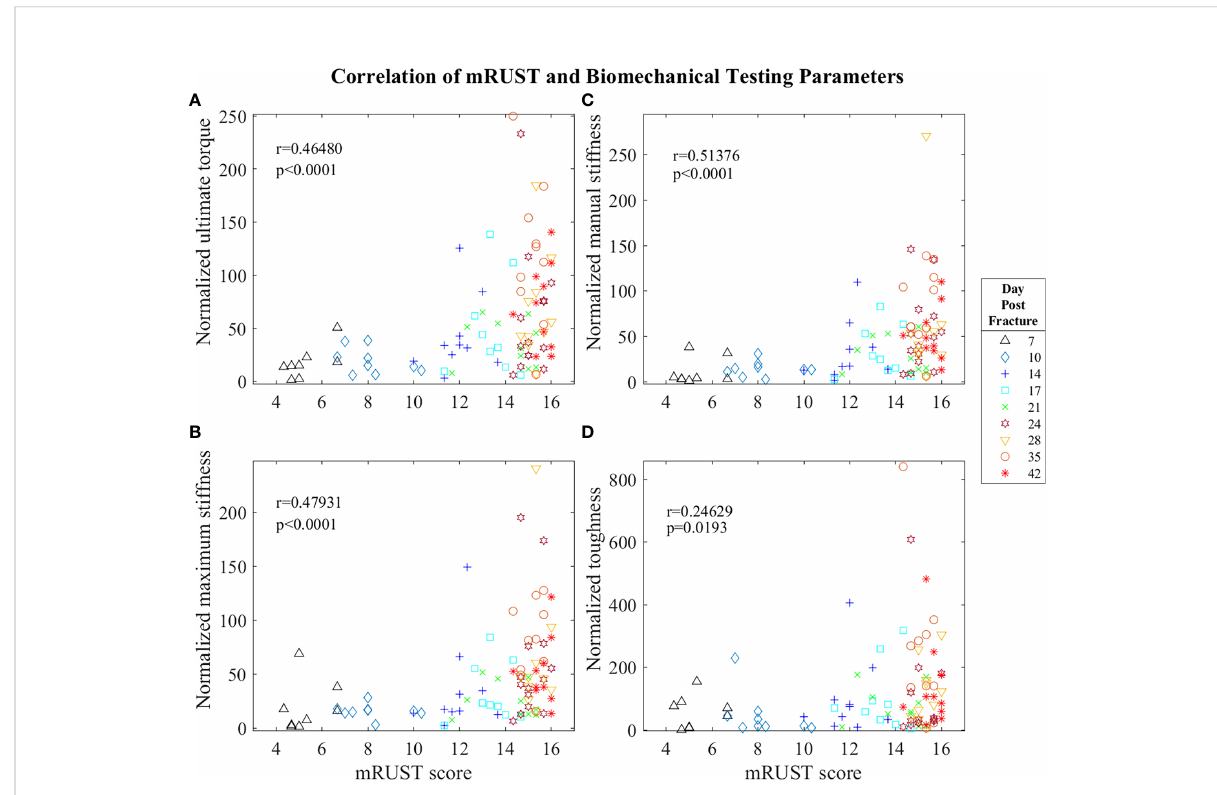
FIGURE 5 Symbol and color plot of mRUST correlations with (A) ultimate torque (% of contralateral), (B) maximum stiffness (% of contralateral), (C) manual stiffness (% of contralateral), and (D) toughness (% of contralateral). Each point represents an individual